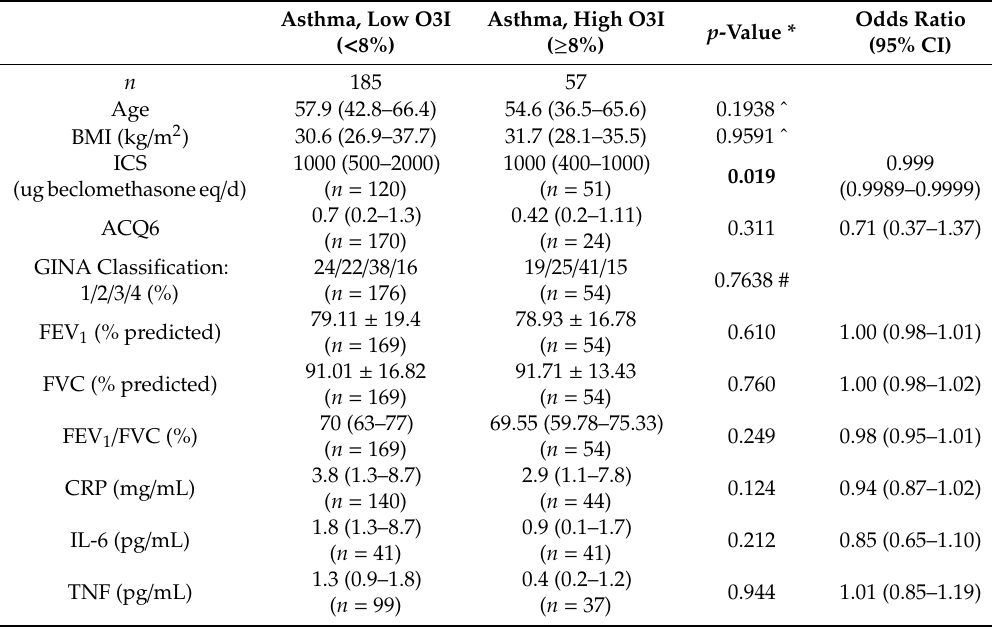
Table 2. Clinical asthma markers of subjects with asthma by O3I status.